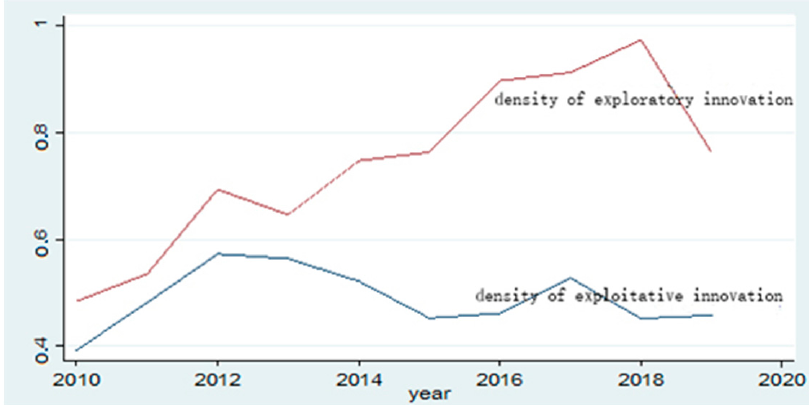
Figure 7. Change curve of density based on dual innovation strategy .